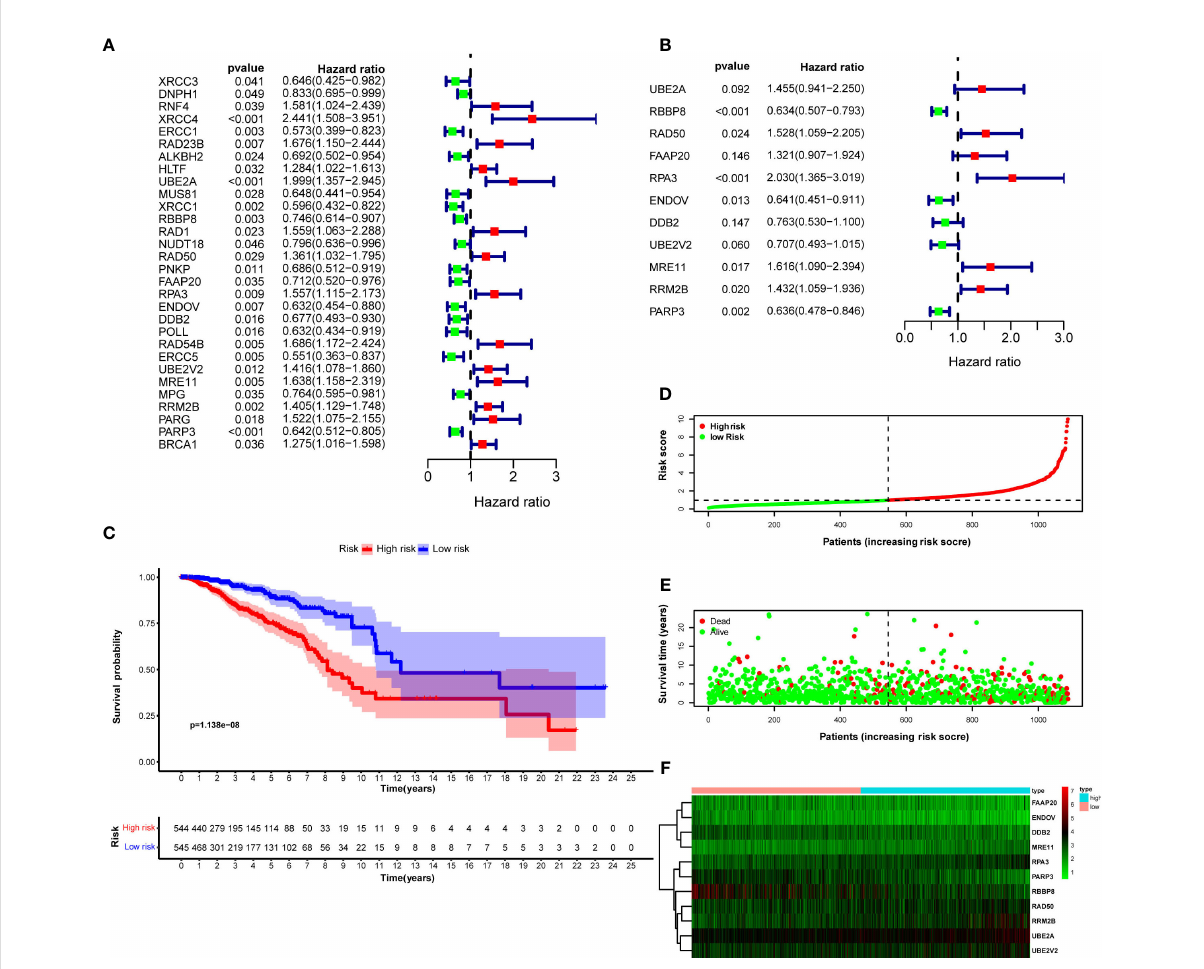
FIGURE 2 DNA repair genes and Kaplan – Meier curve forest plot of the hazard ratio for the high- and low-risk groups. Breast cancer patients were strati fi ed into high- and low-risk groups using risk scores counted by the expression level of prognosis-related DNA repair genes for analysis. (A) Forest plot of 30 prognosis-related DNA repair genes retrieved using univariate Cox regression. (B) Forest plot of 11 prognosis-related genes retrieved using multivariate Cox regression model after optimizing by the AIC value. (C) KM curve of OS for breast cancer patients in the high- and low-risk groups strati fi ed by the median of risk scores. (D) The dotted line displays the individual in fl ection point of the risk score curve and shows that patients are divided into low- and high-risk groups using median risk score; red dots represent patients with high risk; green dots represent patients with low risk. (E) Risk score scatter plot of the high- and low-risk patient groups; red dots show dead patients; green dots show alive patients; the survival time of dead patients decreased with the risk score ascending. (F) Risk score heatmap of 11 prognosis-related DNA repair genes; the expression level of 11 DNA repair genes increased with color varied from green to